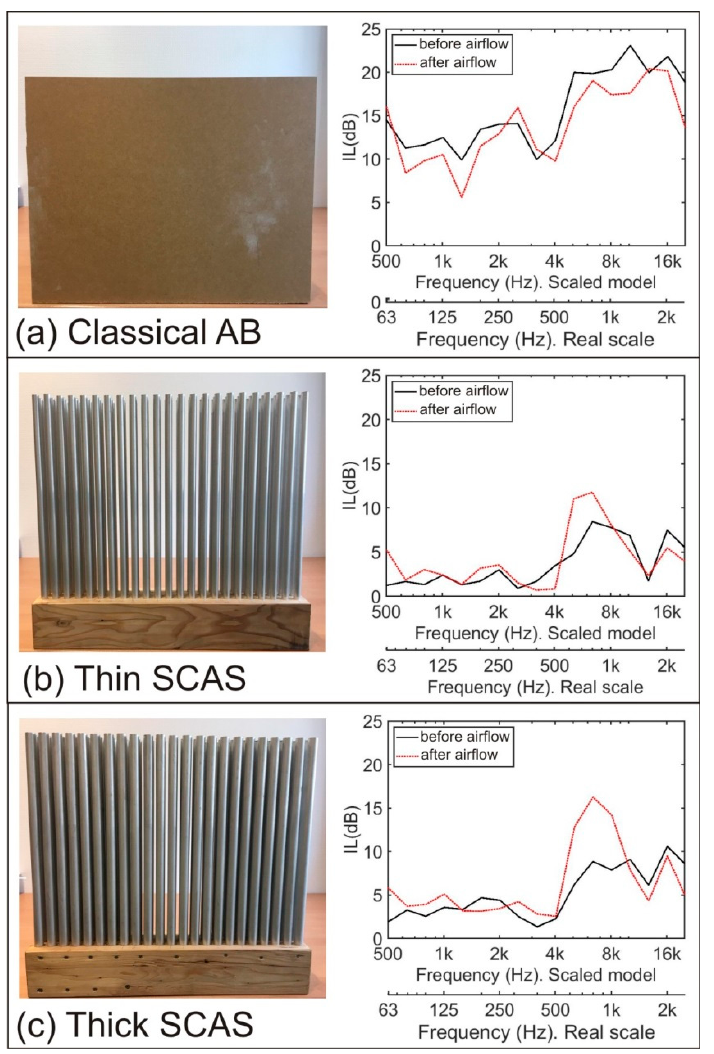
Figure 8. ( a )–( c ) On the left side of the figures you can see a picture of the AB considered in this study; on the right side we show the IL spectra as a function of the frequency for each case before (black continuous line) and after (red dotted line) to apply the air flow.